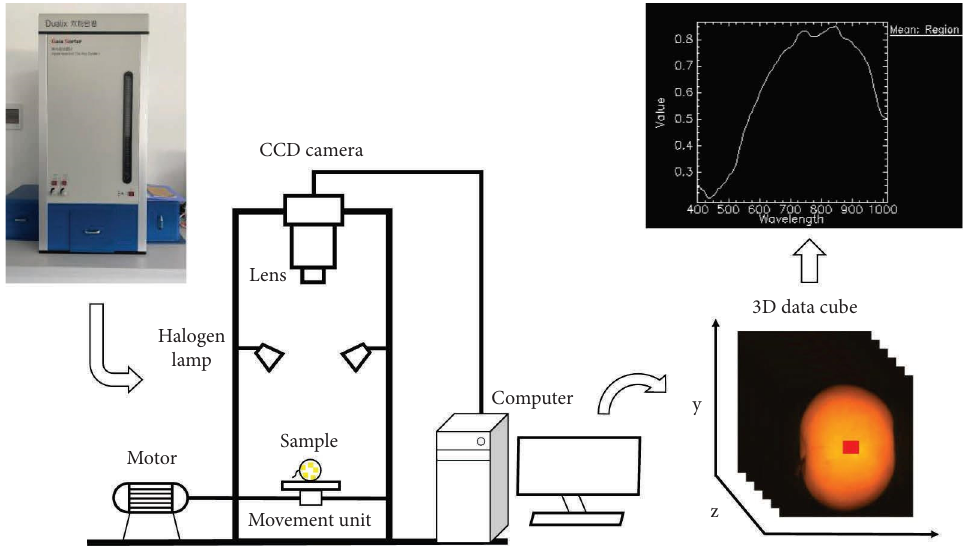
Figure 2: Schematic diagram of a hyperspectral acquisition